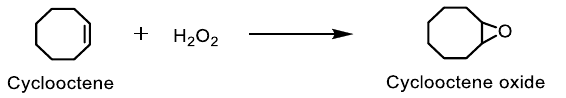
Figure 6. High-resolution XPS spectra in the relevant regions with the corresponding fits for ( A ) MR, ( B ) CAT-4-MR and ( C ) CAT-5-MR .